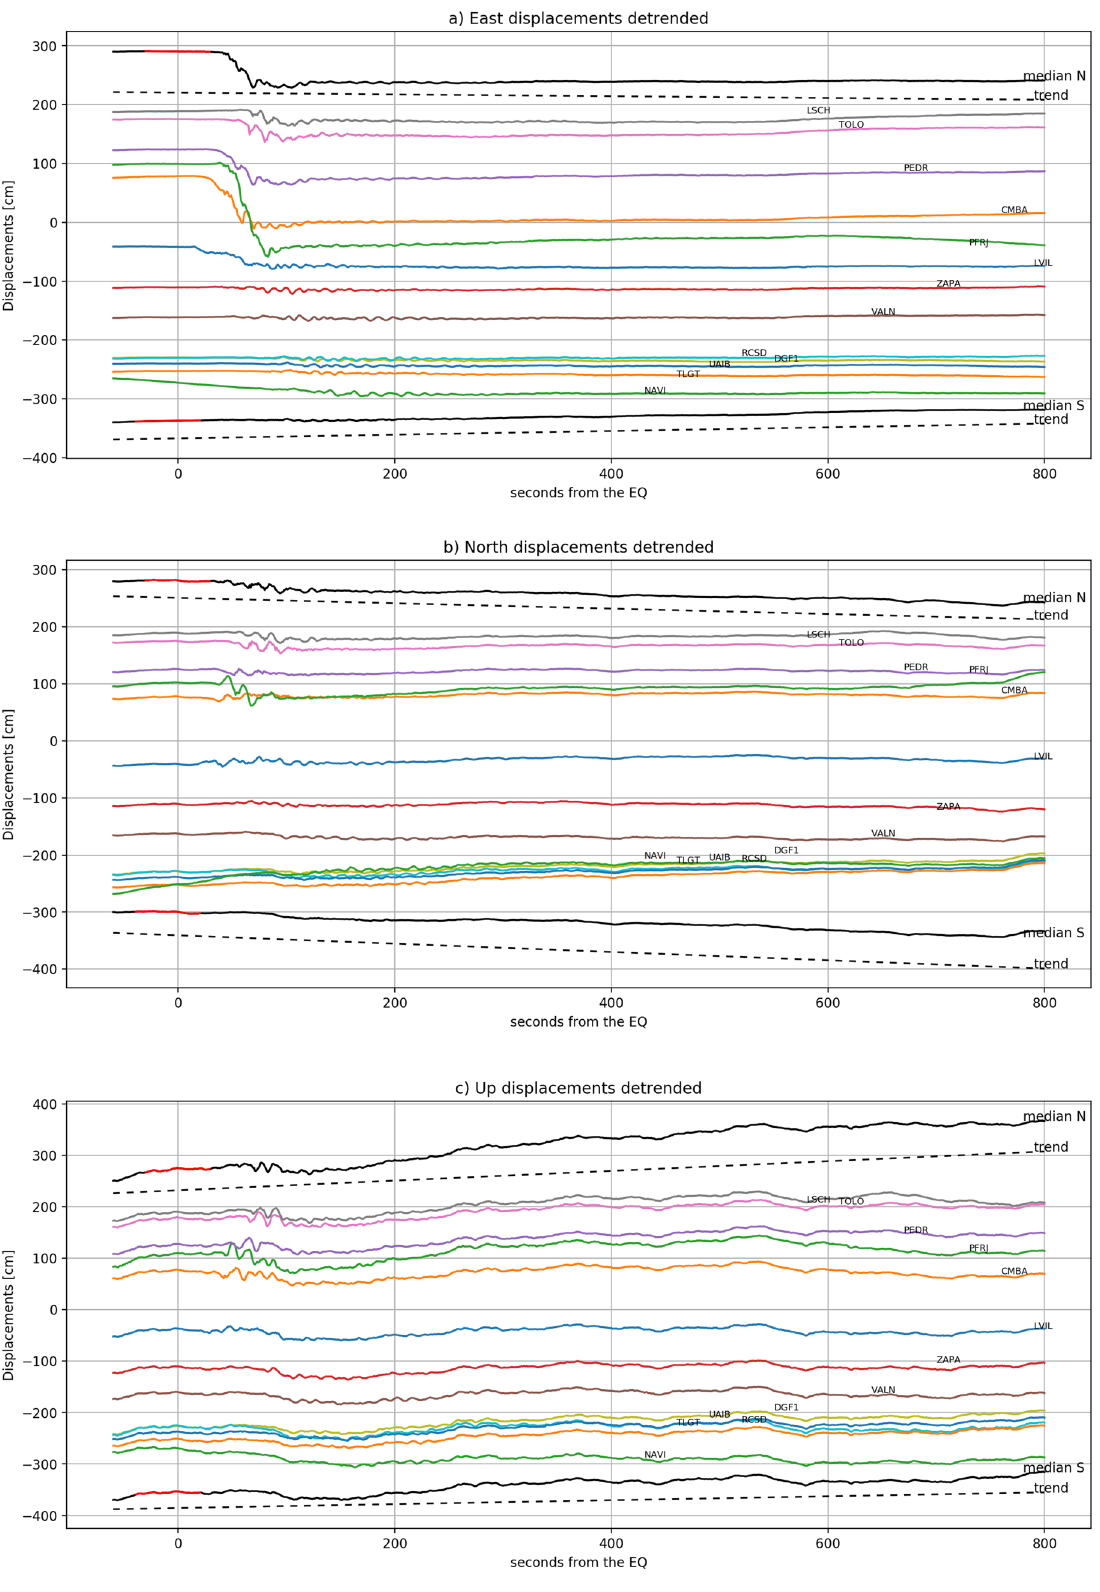
Figure 5. VADASE detrended coseismic displacements for the East (a), North (b) and Up (c) component. The stations are ordered according to their distance from the epicenter (positive distances for north placed stations and negative distances for south placed stations). The spatial median computed for the north and south stations is depicted in black; the red part highlights the interval over which the robust linear fit was estimated, whereas the dashed line represents the extrapolated